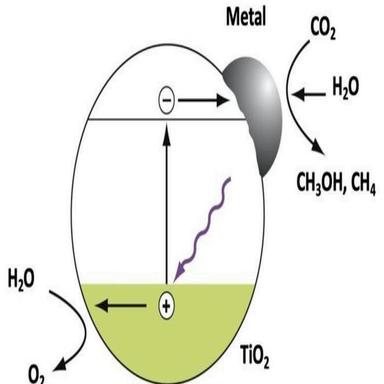
A diagram of electron-hole separation in semiconductor upon light adsorption (middle), the hole transport to participate the water oxidation reaction (left), and electron travels to catalytic site for reduction of carbon dioxide (right).